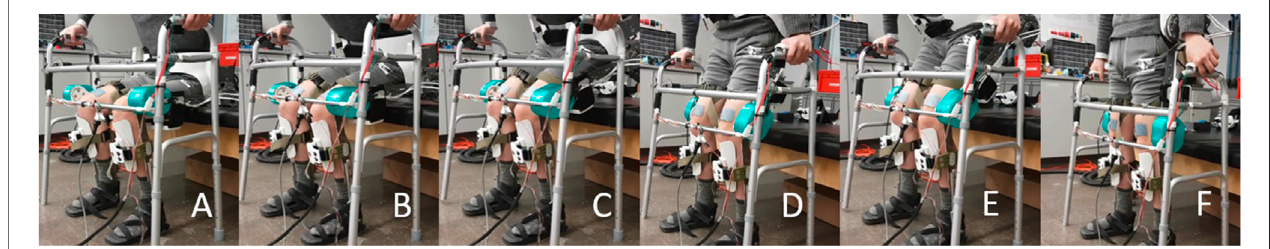
FIGURE 2 | Snapshots of one sit-to-stand trial for Participant 1.